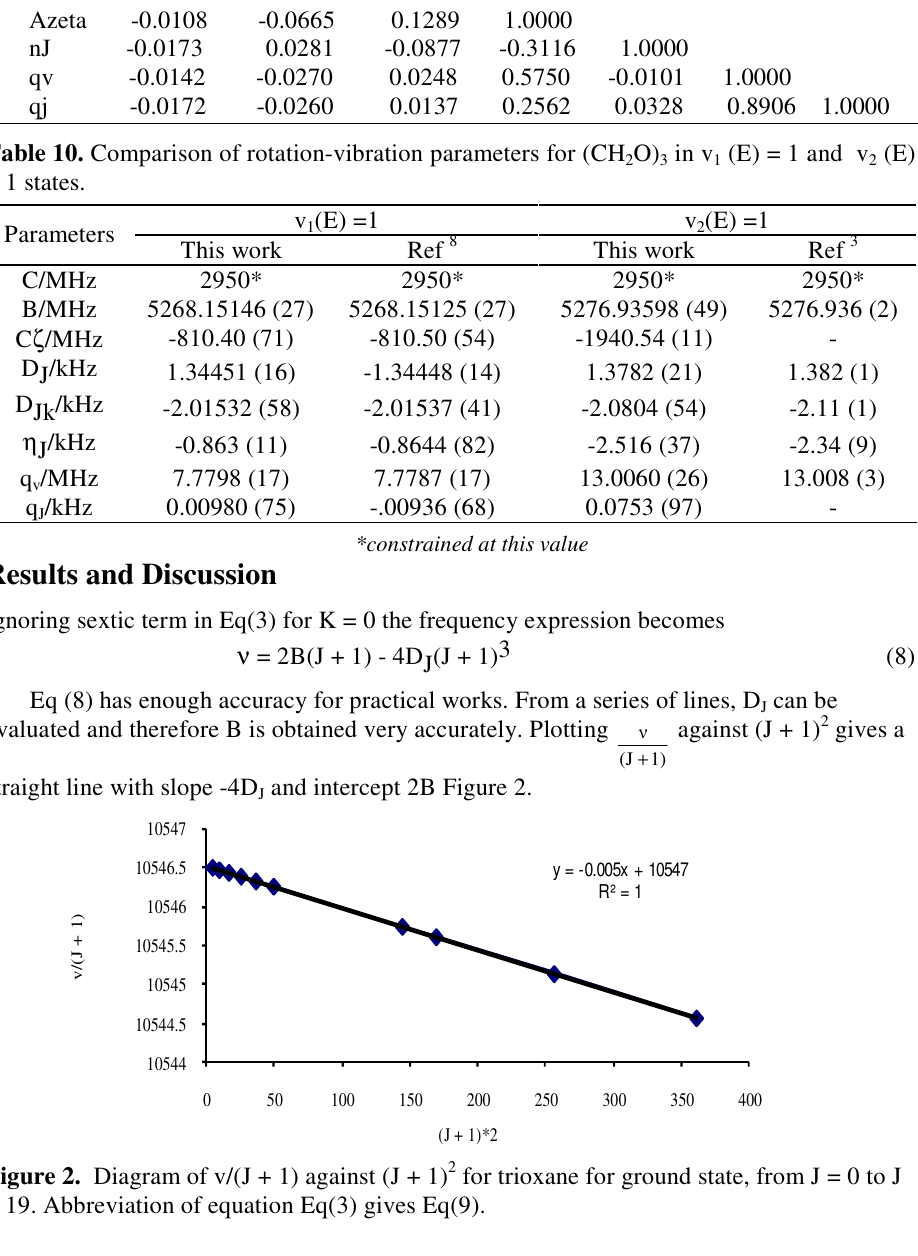
Table 9. Correlation coefficients of obtained parameters for (CH